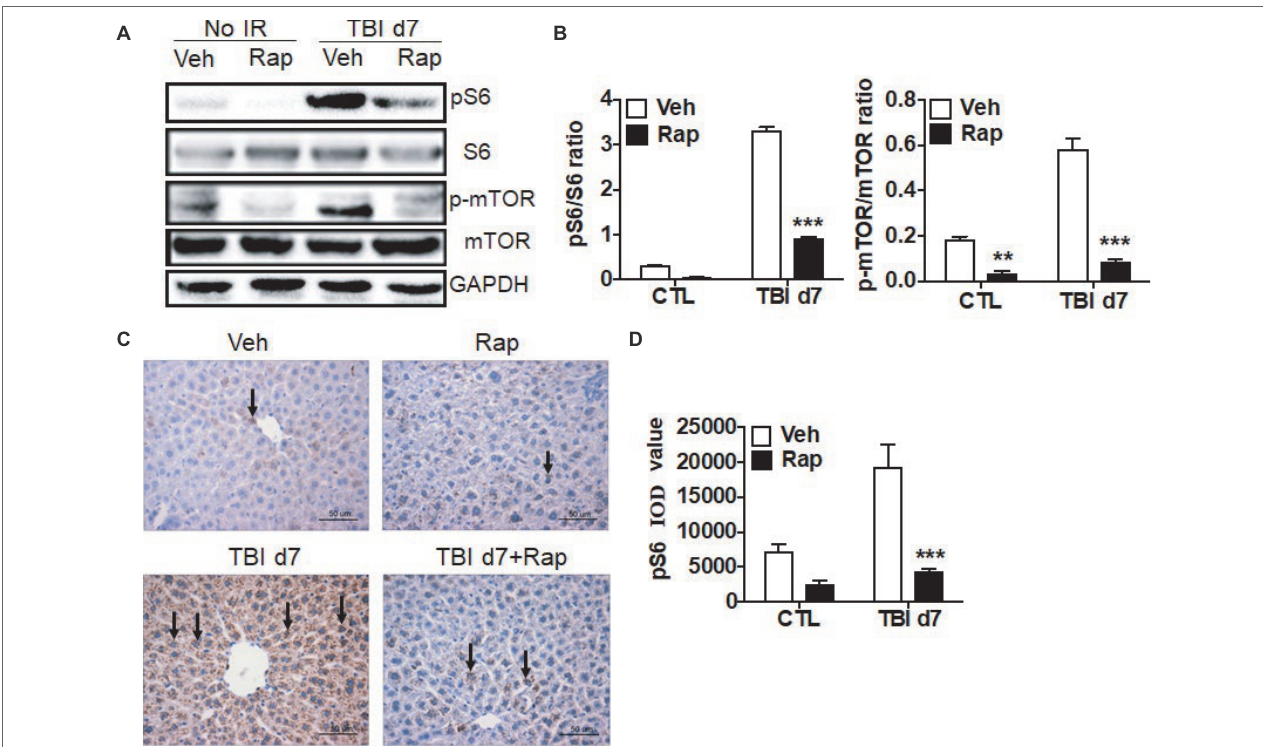
FIGURE 4 | Rapamycin treatment reduced the increase of pS6 expression in irradiated liver tissues. (A and B) Increased expression of pS6 and p-mTOR by irradiation was reduced through rapamycin (Rap) treatment. Expression of pS6, S6, p-mTOR, and mTOR (A) was detected by western blotting at day 7 after irradiation ( n = 3). GAPDH was used as a housekeeping control. Expression of pS6, S6, p-mTOR, and mTOR (B) was quantitated by ImageJ software. The ratios of pS6/S6 and p-mTOR/mTOR are presented. (C and D) pS6 immunostaining in liver tissues ( n = 6). Liver tissues with or without rapamycin treatment were harvested at day 7 post-irradiation and fixed in 4% paraformaldehyde after irradiation, and pS6 immunostaining was performed as indicated in materials and methods (C) . Scale bar = 50 μ m. Arrows indicate pS6-positive cells. Imaging software was used to analyze the integrated optical density (IOD) of pS6 (D) . ** p < 0.01, *** p < 0.001 vs.